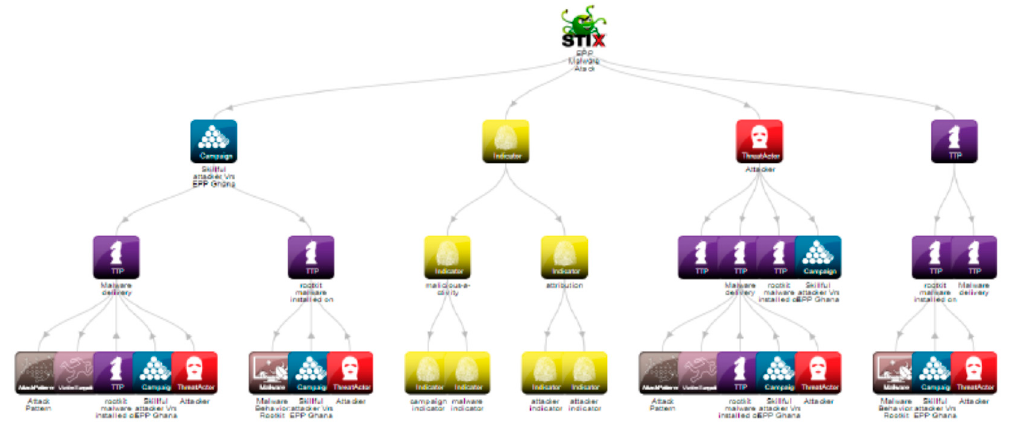
Figure 5. STIXviz tool. Cyber attack modeling and attribution.